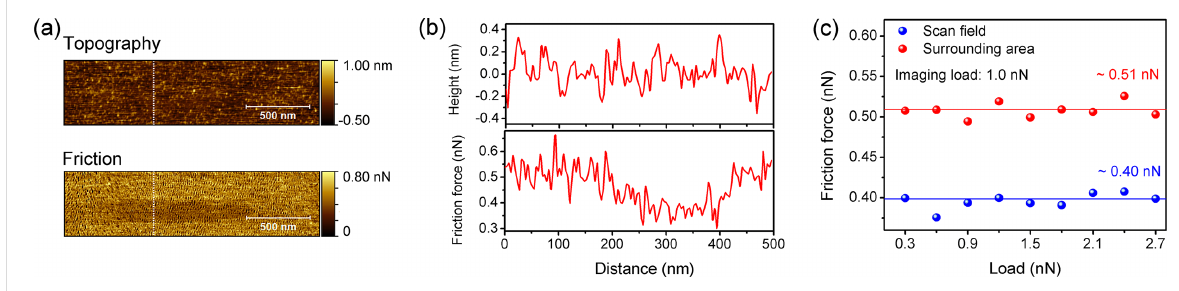
Figure 3: (a) AFM topography and friction force images recorded on Zr 63 Ni 22 Ti 15 metallic glass after immersion into 0.2 M NaCl solution for 72 h and after scanning the central area (1.0 × 0.125 μ m 2 ) 16 times at a normal load of 1.5 nN (imaging load: 1.0 nN); (b) cross section of the topography and friction image corresponding to the lines drawn in (a); (c) friction force of the scan field and surrounding area as a function of the normal load applied during 16 repetitive scans in the scan field. Friction data were extracted from images recorded at an imaging load of 1.0 nN.